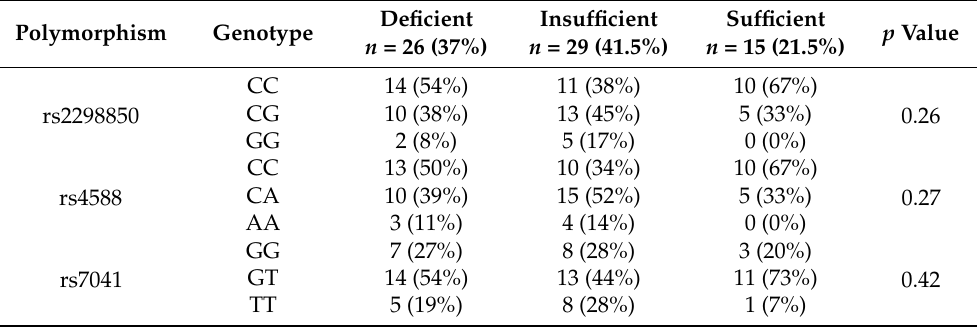
Table 4. Distribution of neonatal vitamin D status according to neonatal VDBP genotype polymor- phisms.